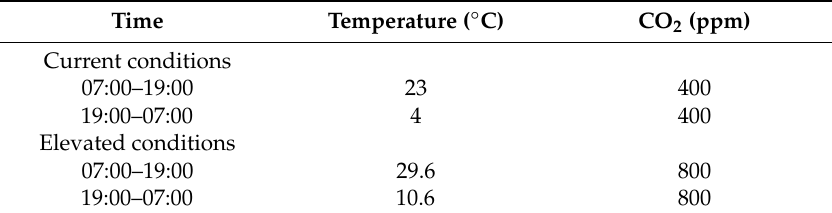
Table 1. Climate treatments, including time (24 h clock) during which temperature and carbon dioxide (CO 2 ) conditions were administered, temperature ( ◦ C), and CO 2 (parts per million, ppm). Time Temperature ( ◦ C) CO 2 (ppm) Current conditions